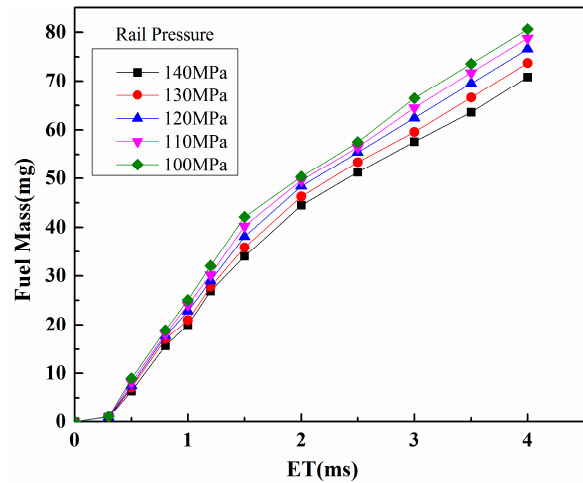
Figure 12. Map for injector characteristics.